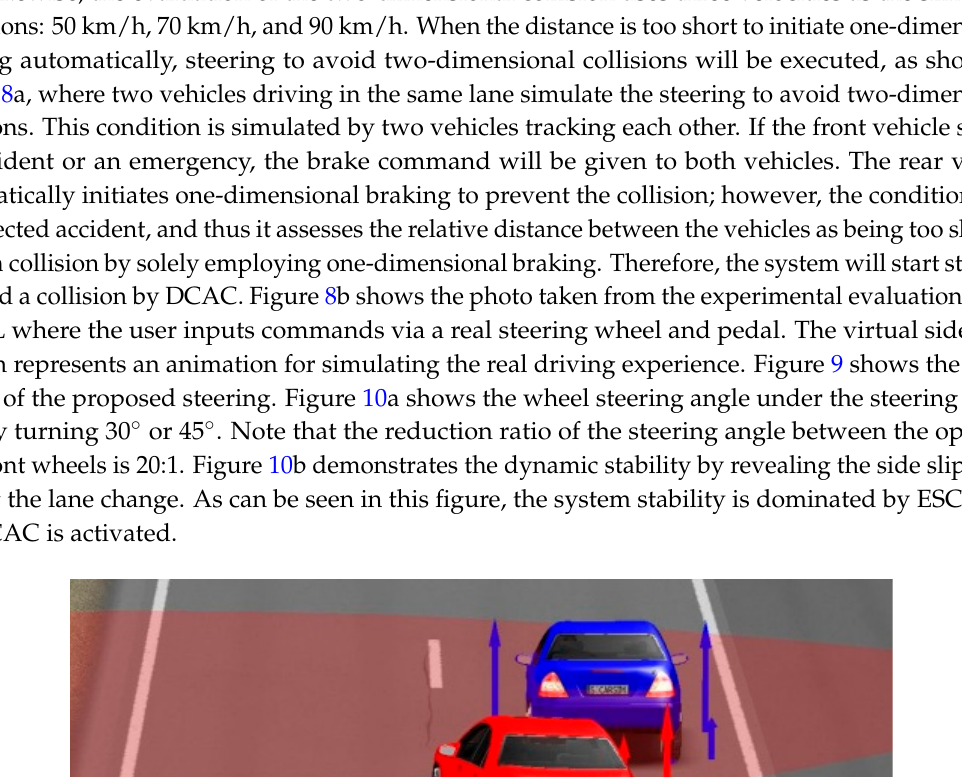
( b ) Evaluation via HIL ( hardware-in-the-loop ). Figure 8. Environmental setup of the evaluations.